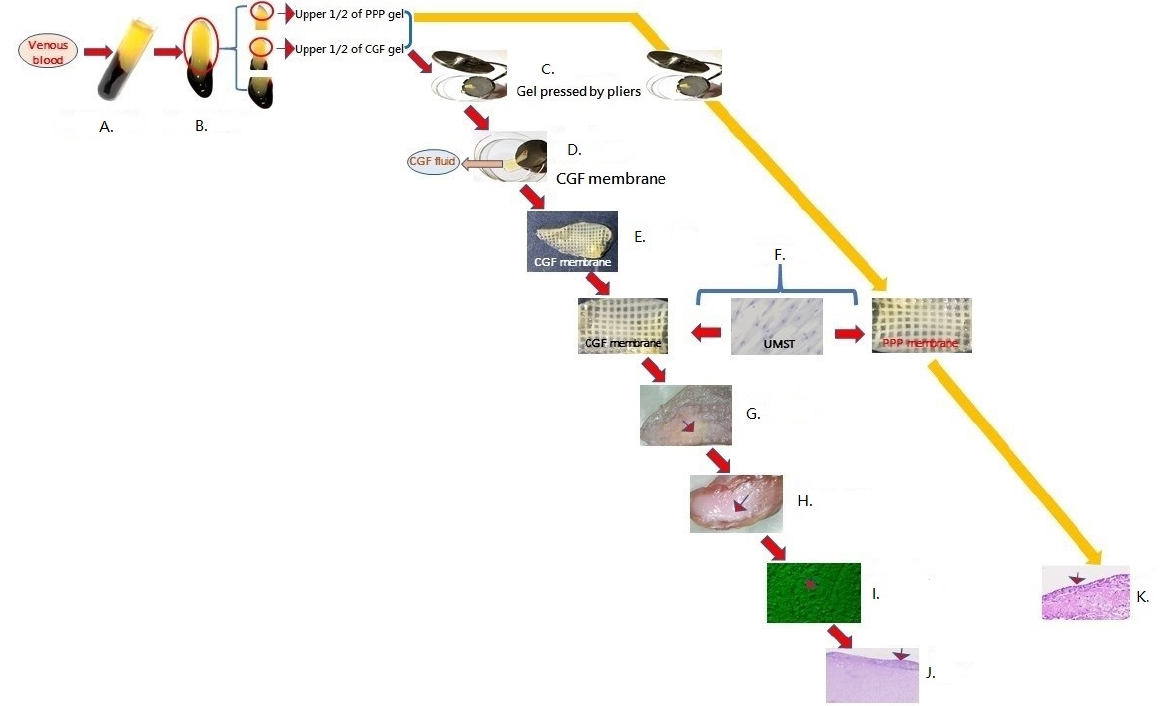
Figure 1. Flow chart showing the preparation of concentrated growth factors (CGF) or platelet-poor plasma (PPP) gel and membrane from venous blood. The CGF membrane and PPP membrane used as scaffolds for culturing umbilical cord mesenchymal stem cells in vitro. ( A ): CGF gel formed after fractional gradient centrifugation of venous blood. ( B ): The upper half of the PPP gel used for the preparation of PPP membrane. The upper half of the CGF gel used for the preparation of the CGF membrane and fluid. ( C ): the upper half of the CGF gel compressed by pliers. ( D ): after compression, CGF gel separated into the CGF membrane and CGF fluid. ( E ): CGF membrane used as a scaffold for cell culture. ( F ): Umbilical cord mesenchymal stem cells seeded onto the CGF membrane or PPP membrane. The above 2 kinds of membrane used as scaffolds for culturing umbilical cord mesenchymal stem cells in vitro. ( G ): photograph of umbilical cord mesenchymal stem cells and CGF membrane cultured for 2 weeks (